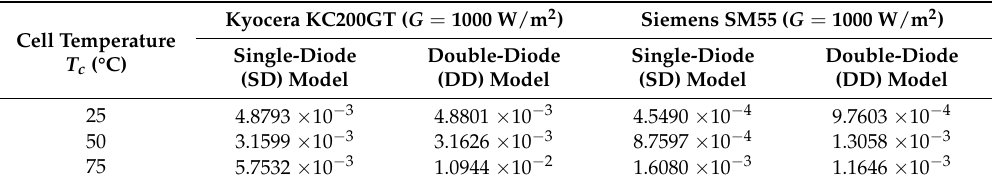
Table 7. RMSE values between the measured and estimated I-V characteristics at different cell temperatures (25, 50 and 75 ◦ C ) and fixed solar irradiance ( G = 1000 W/m 2 ), extracted from an individual PV cell from both the Kyocera KC200GT and Siemens SM55 Solar Panels.